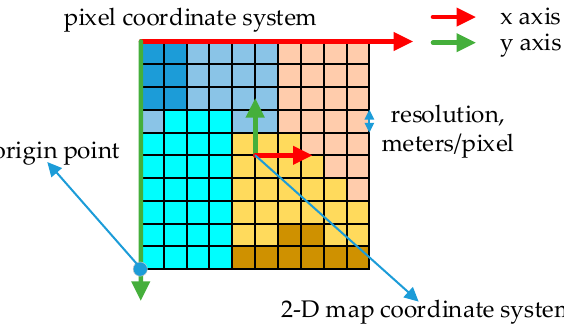
Figure 4. Relations between coordinate systems in the picture in ppm format.